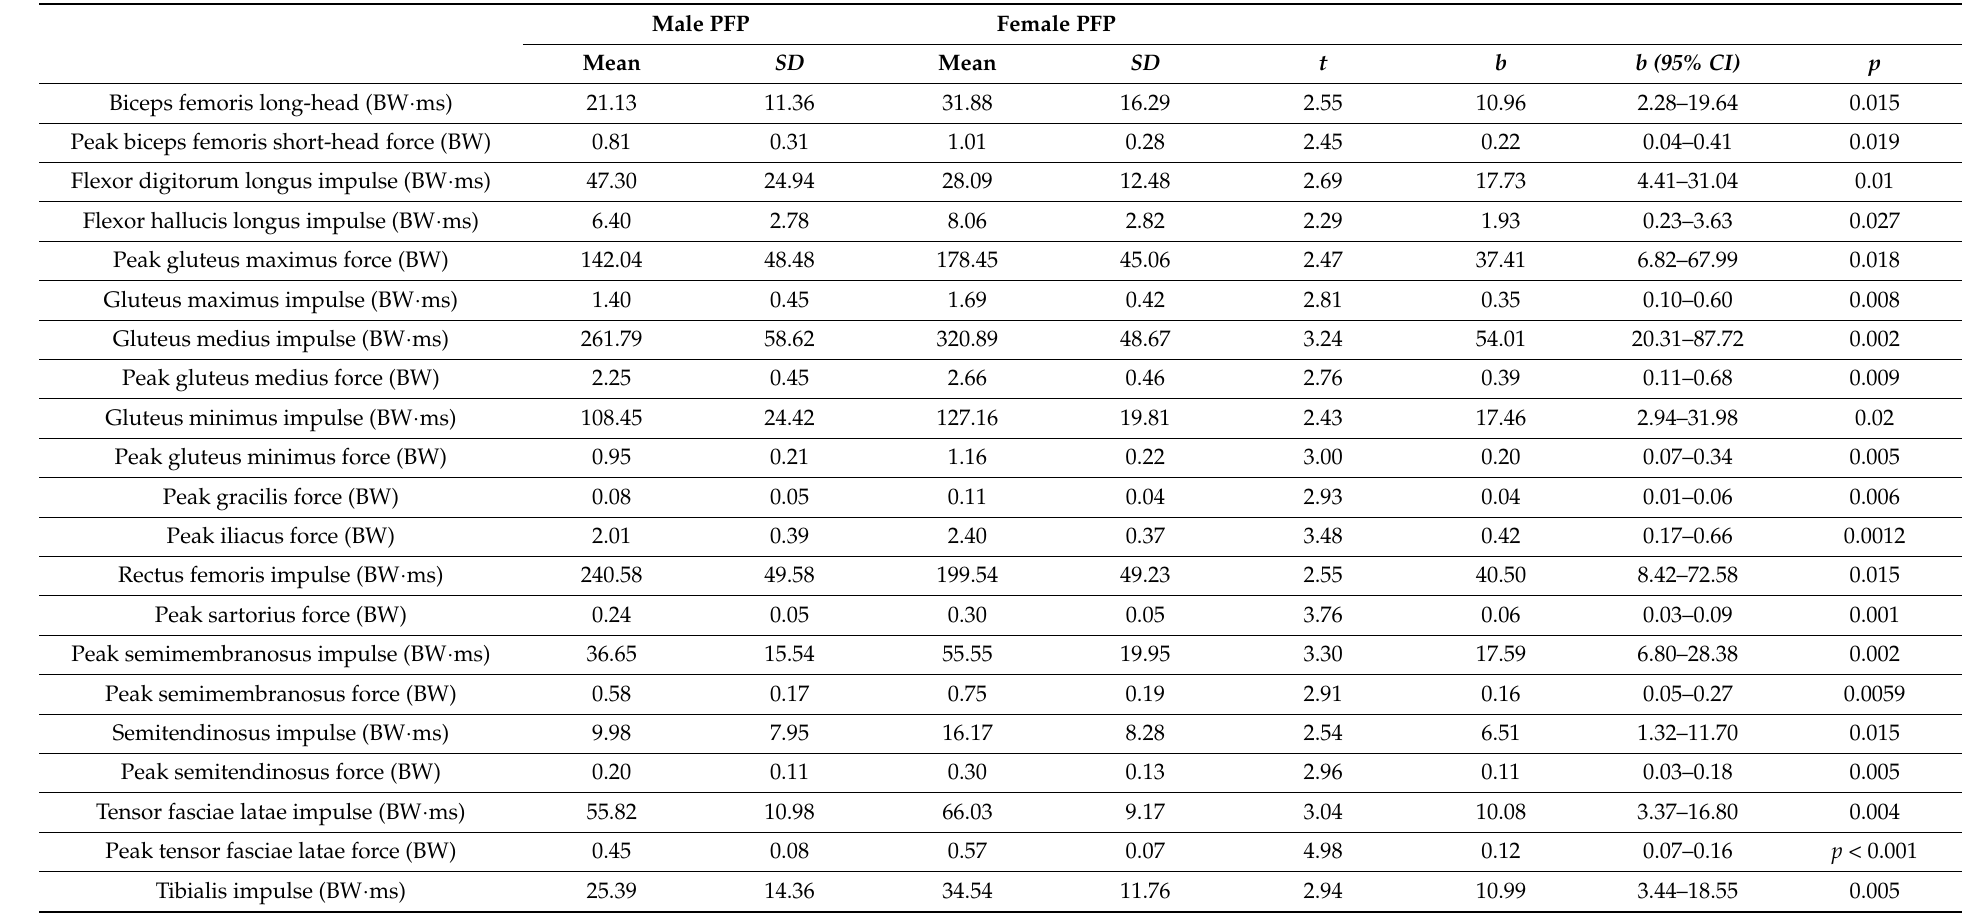
Table 12. Muscle force indices in male and female PFP